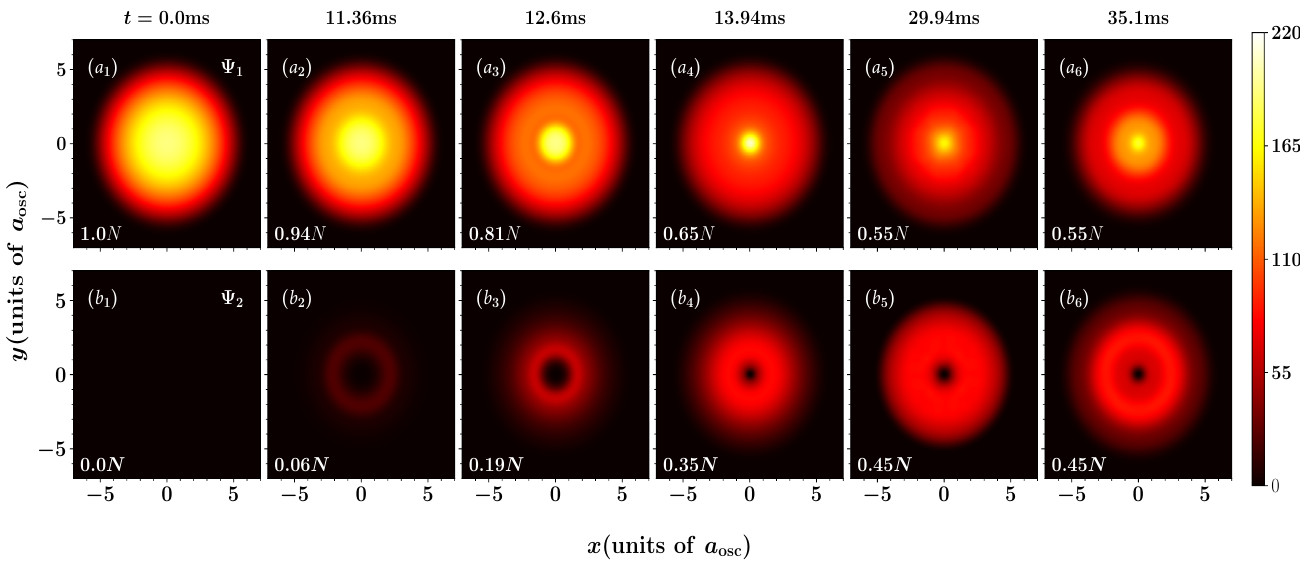
Figure 6. (Color online) Shows the time evolution (see the legends) of the density profiles of the BEC Ψ 1 at ( a 1 – a 6 ) | 1 (cid:105) and those of BEC Ψ 2 at ( b 1 – b 6 ) | 2 (cid:105) . The population transfer from Ψ 1 to Ψ 2 is triggered by utilizing a LG(pump)–G(stokes) pulse sequence and setting the light–matter interaction parameter V max = 1 and the interspecies scattering length a 12 = 80 a 0 , while all other parameters are the same as before. The fraction of atoms the condensate with respect to the total number of atoms N = 10 4 , is mentioned at the bottom left corner of each